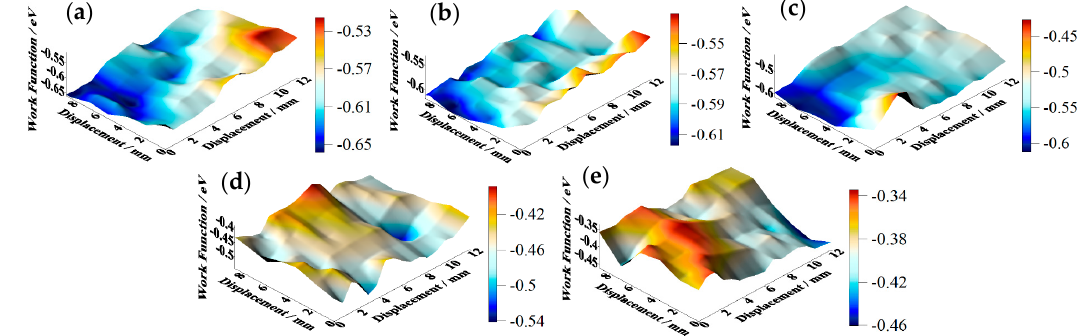
Figure 8. Work function maps of the tinplate samples treated with ( a ) reflowing before passivation; ( b , c ) chemical passivation for 3 s and 6 s, respectively; and ( d , e ) electrolytic passivation for 3 s and 6 s, respectively.